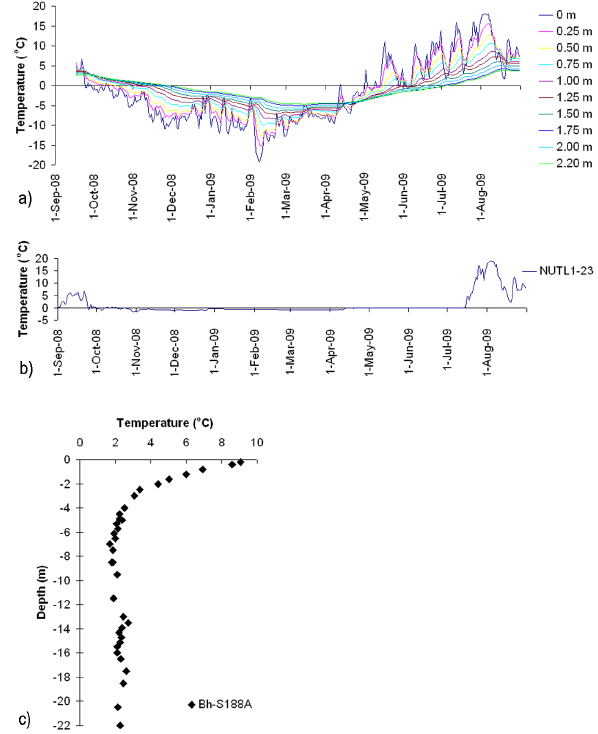
Figure 4. Examples of the three di ff erent data types collected as part of the TSP NORWAY research project, all collected in the North Scandinavian Permafrost Observatory. (a) temperature time- series from monitoring in the borehole NO-B-3 in the Nordnes study area, (b) temperature time-series from micrometeorological monitoring at the site NUTL1-23 (surface temperature time series illustrating the e ff ect of a thick long-lasting snow cover) at Nordnes, and (c) temperature-depth profile from manual borehole logging of the Bh-S188A borehole in the Bidjovagge study